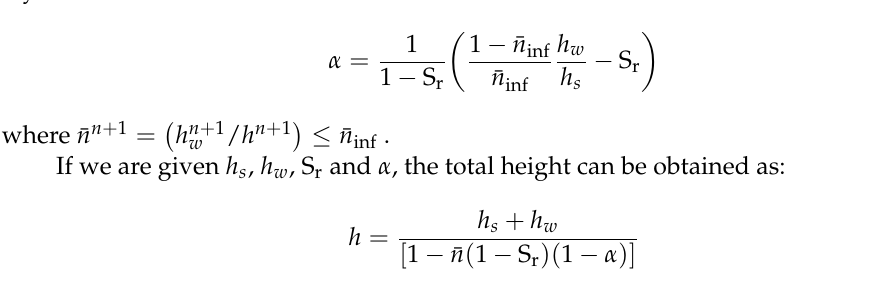
where ¯ n is the averaged